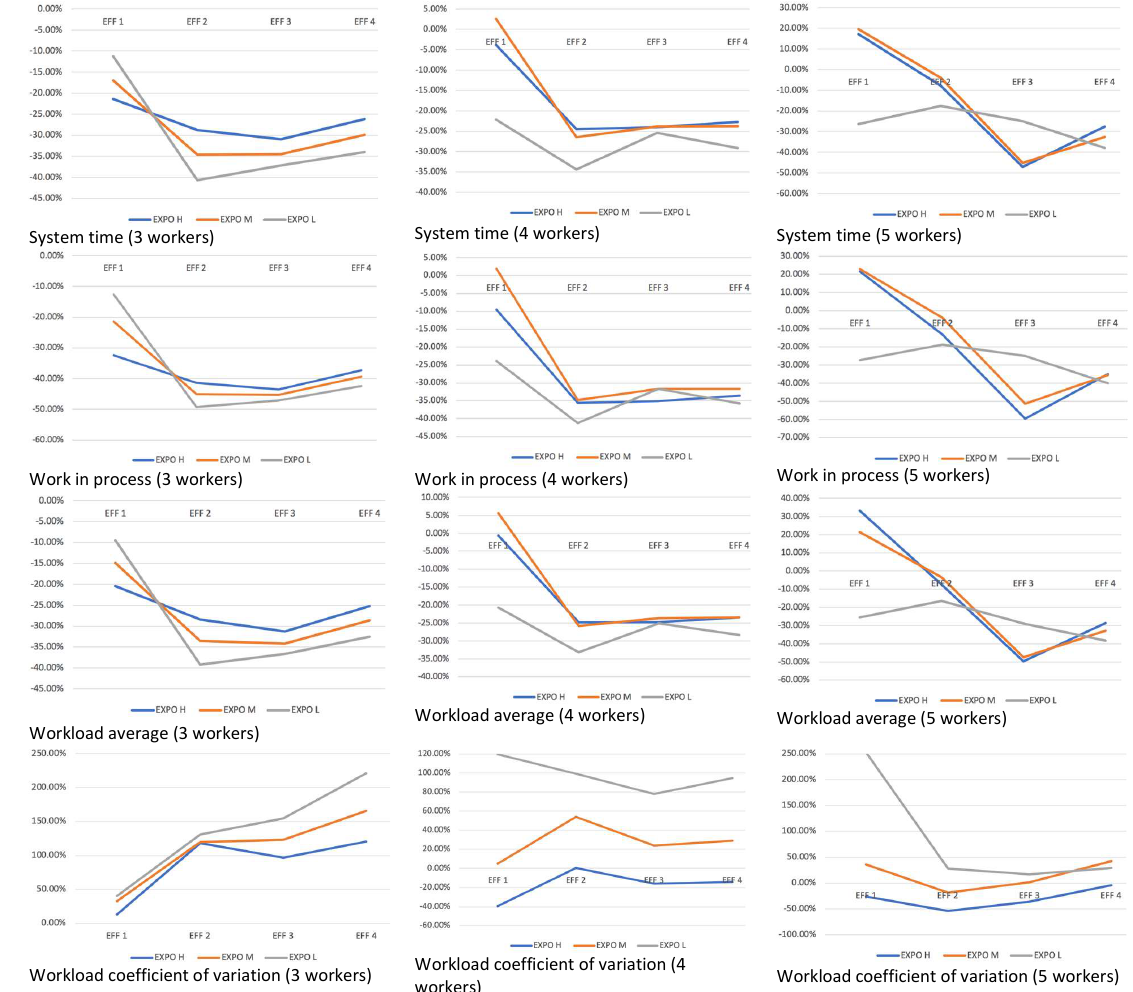
Fig. 2. Performance Assessment - Manufacturing System